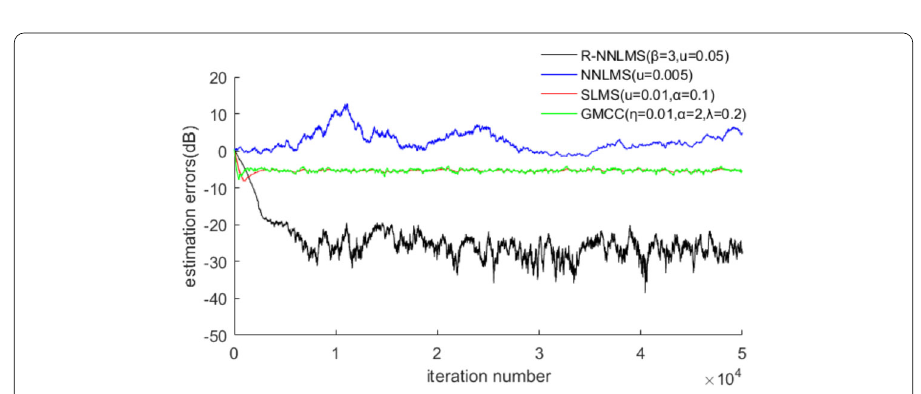
Figure 5 Estimated error of the R-NNLMS and other algorithms in an additional environment of impulsive noise (Pr( w = 0) = 0.5) with the background noise of SNR = 10